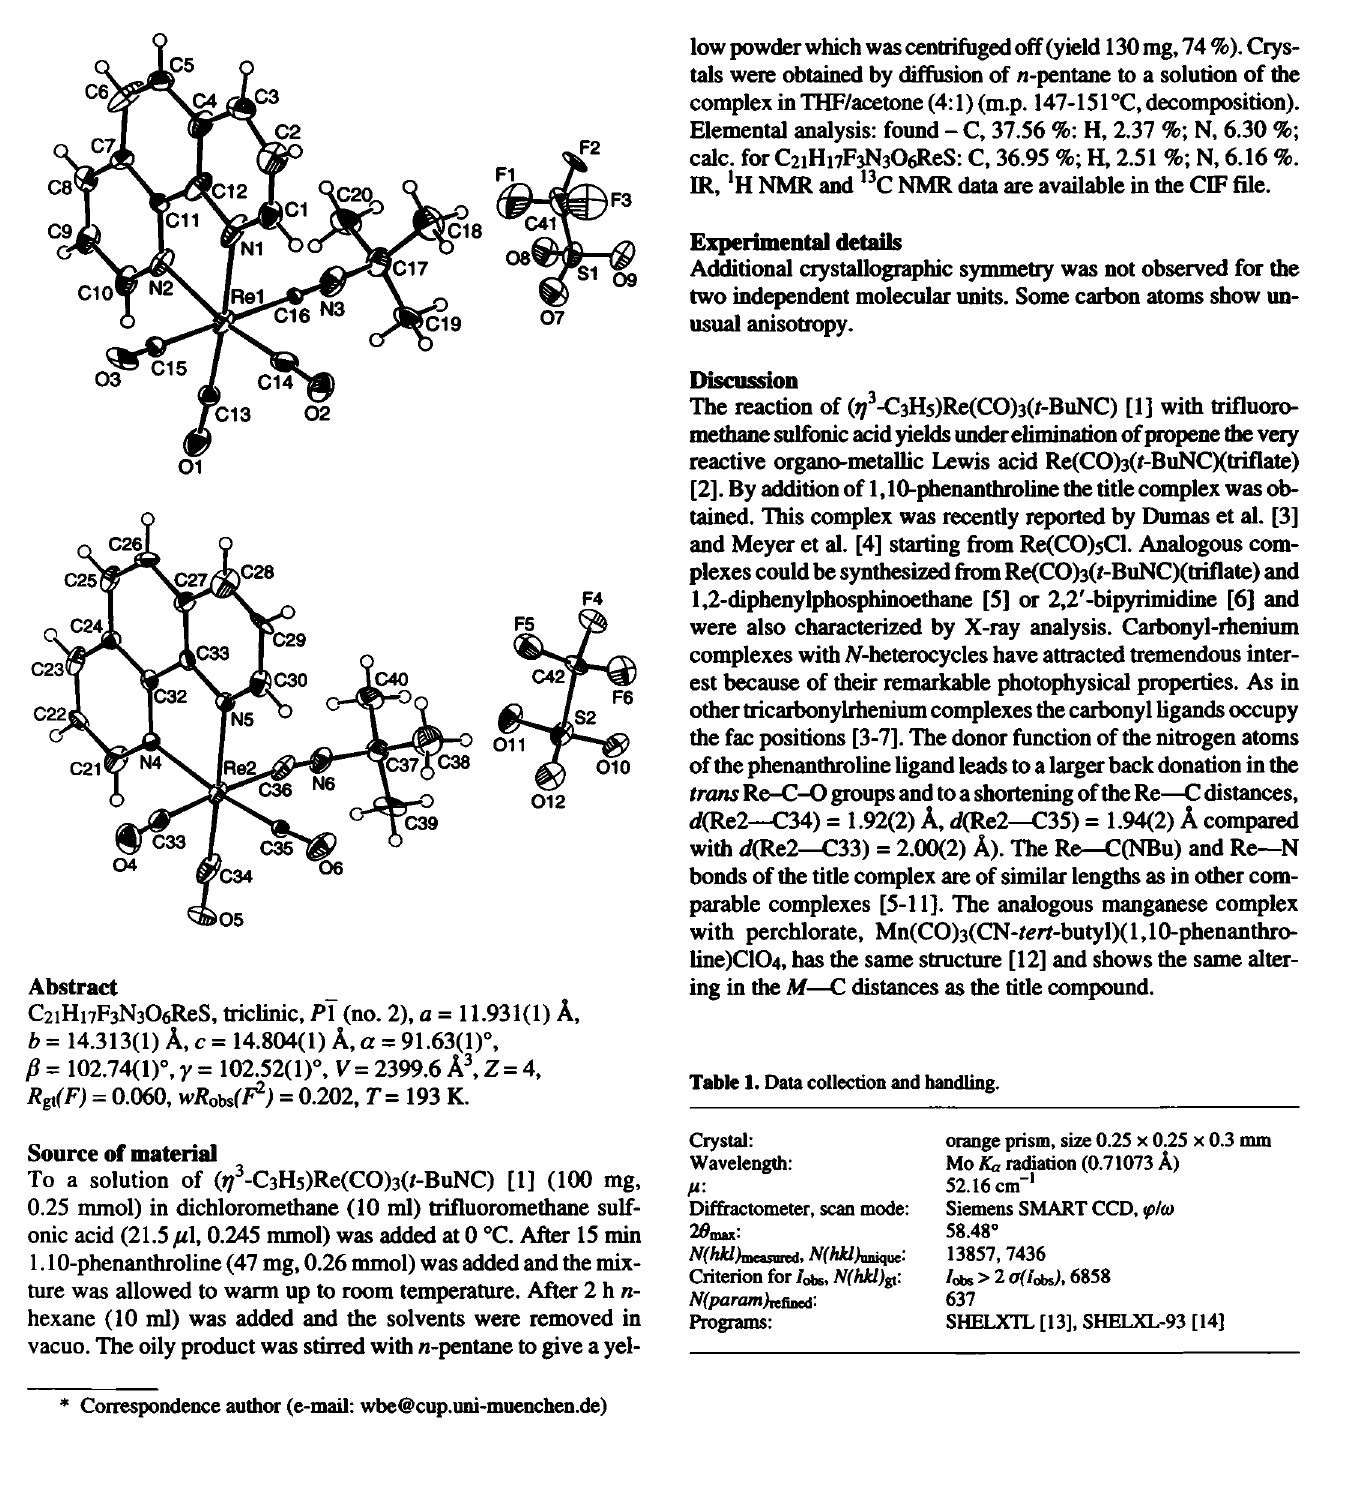
Table 1. Data collection and handling. Crystal: